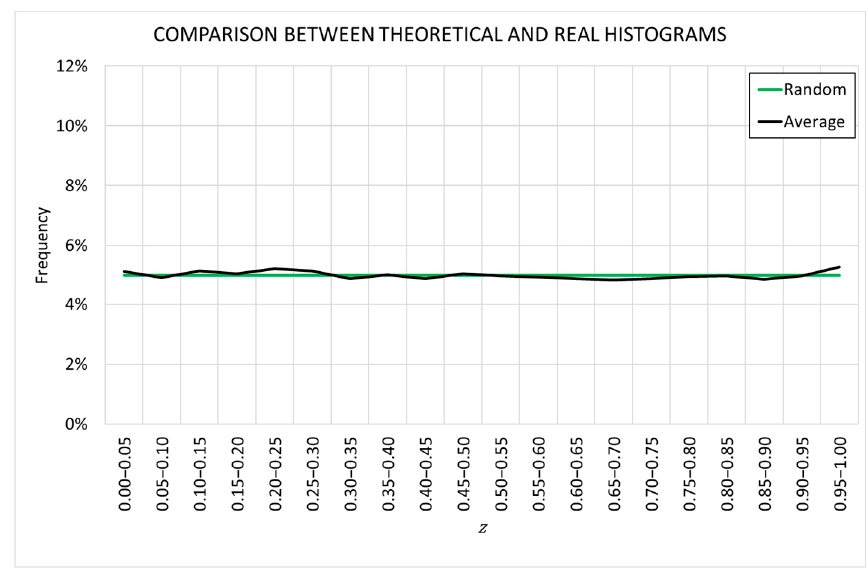
Figure 15. Vertical test. Comparison between real and theoretical histograms.